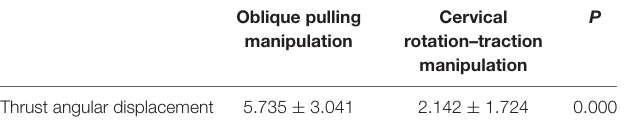
TABLE 4 | Comparison of thrust angular displacement between the two groups ( ◦